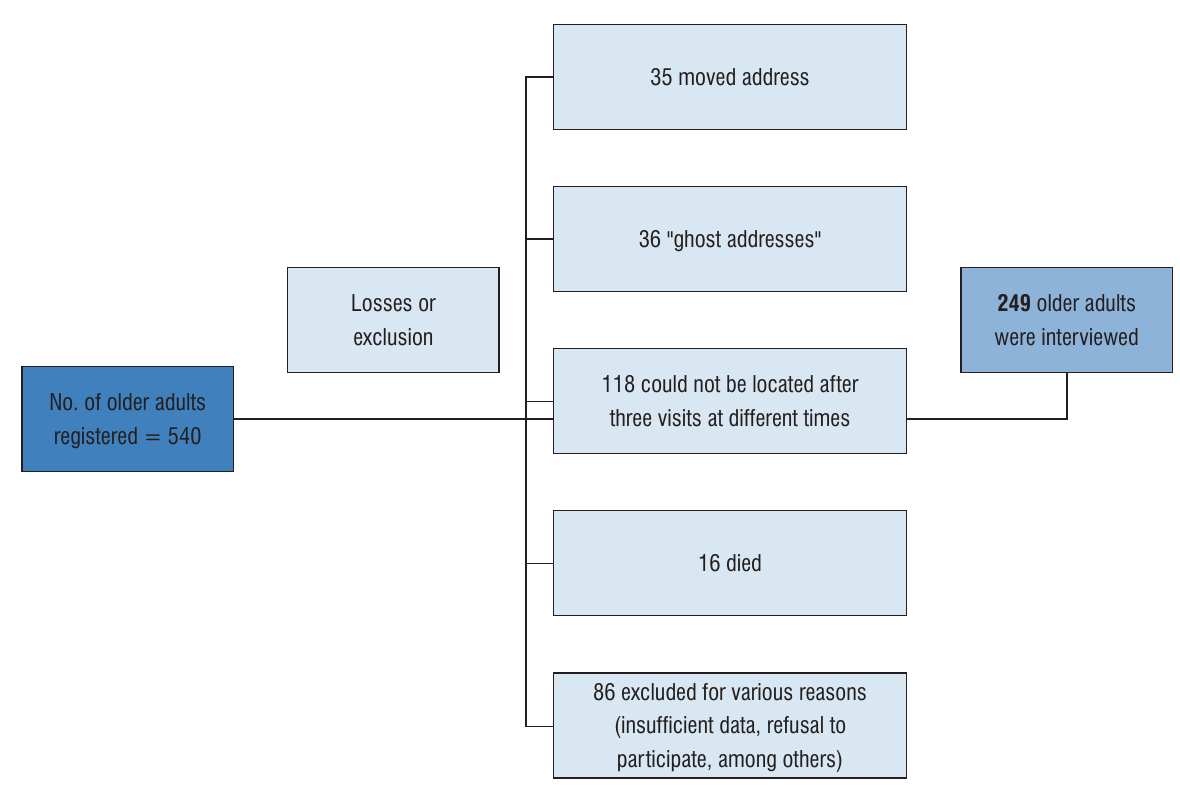
Figure 1 - Study population